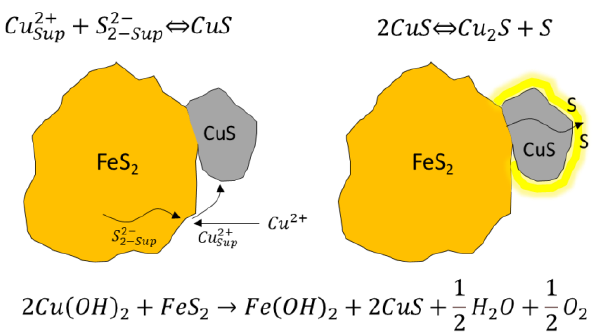
Figure 30. Schematization of pyrite activation by Cu 2+ ions and subsequent sulfur